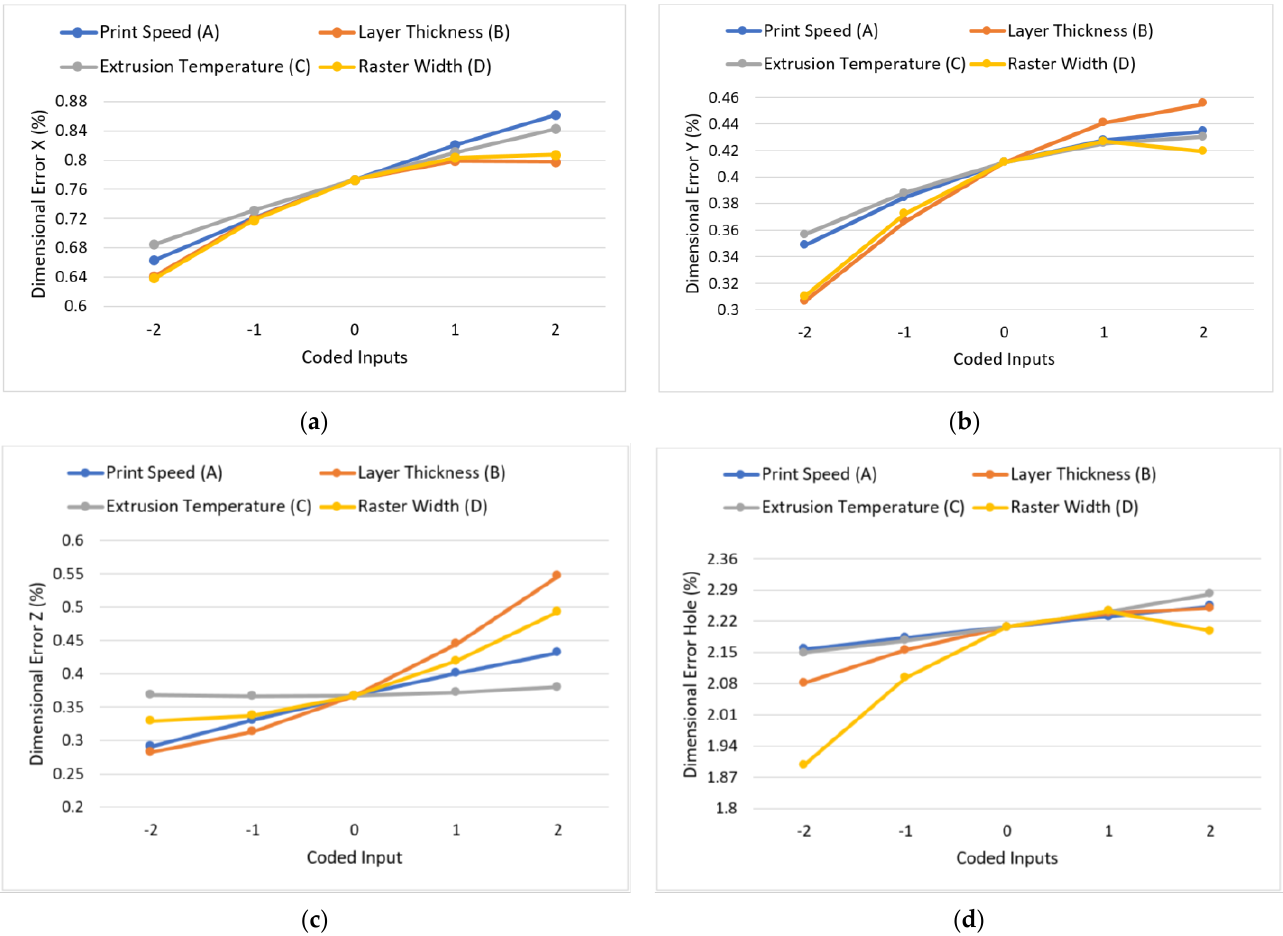
Figure 10. Effect of variation of input parameters on ( a ) dimensional error in X (%), ( b ) dimensional error in Y (%), ( c ) dimensional error in Z (%) and ( d ) dimensional error in hole (%).